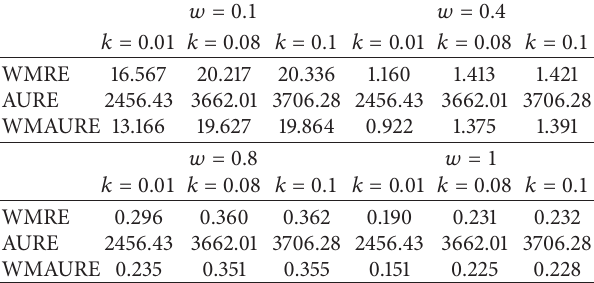
Table1:EstimatedQBvaluesoftheWMRE,AURE,andWMAURE. 𝑤 = 0.1